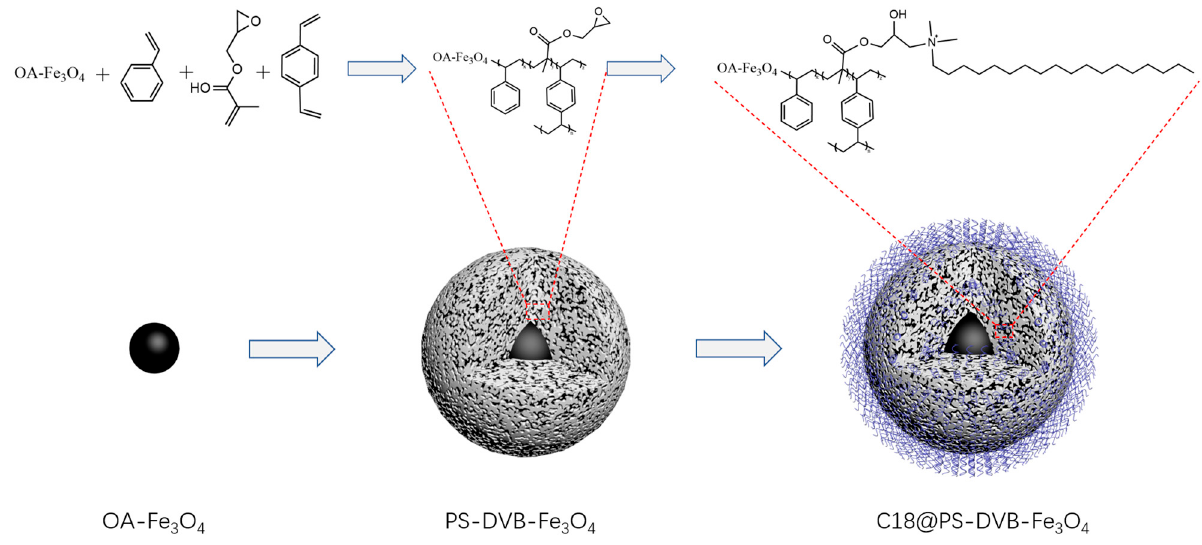
Figure 1. The preparation procedure of the C18@PS-DVB-Fe 3 O 4 particles.